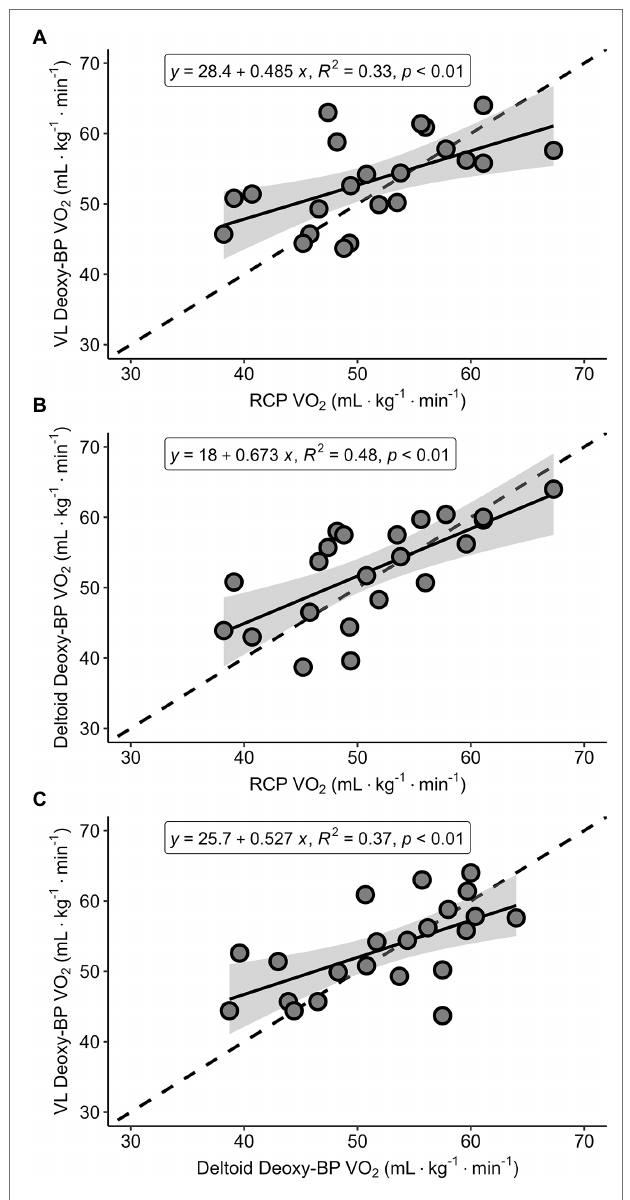
FIGURE 4 | Regression analyses for V ̇ O 2 (ml·kg − 1 ·min − 1 ) between RCP and VL Deoxy-BP (panel A ), RCP and deltoid Deoxy-BP (panel B ), and VL Deoxy- BP and deltoid Deoxy-BP (panel C